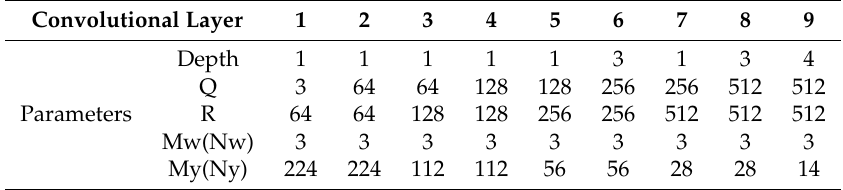
Table 2. Parameters of the convolutional layers in the Visual Geometry Group (VGG)